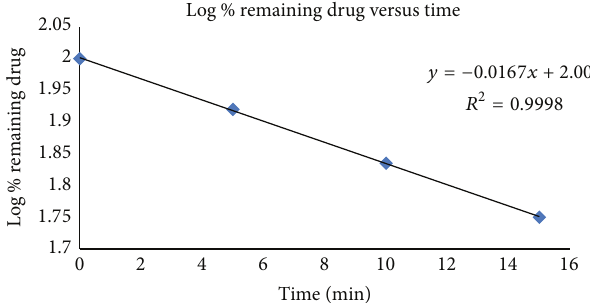
Figure 7: Effect of NaOH (1M) on the degradation of